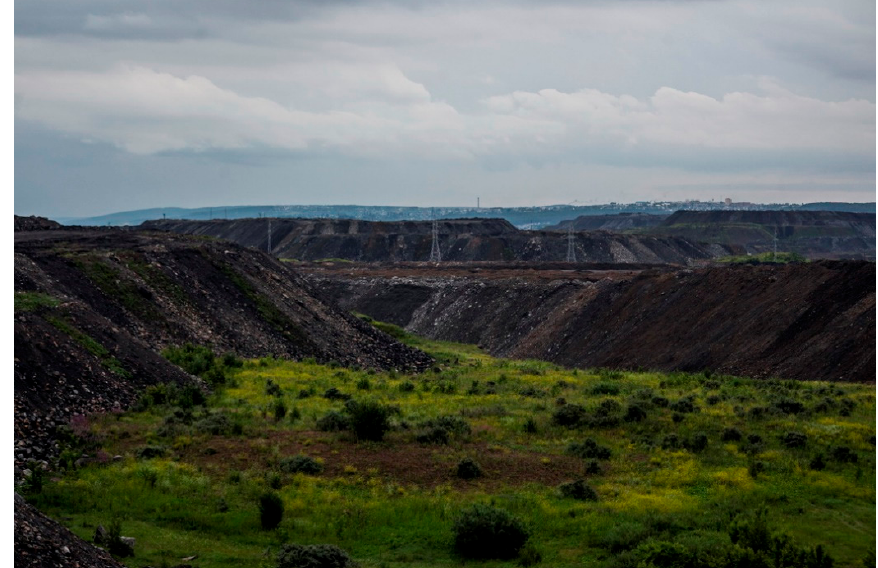
Figure 1. The view of external dumps of surface coal mines in Kuzbass.